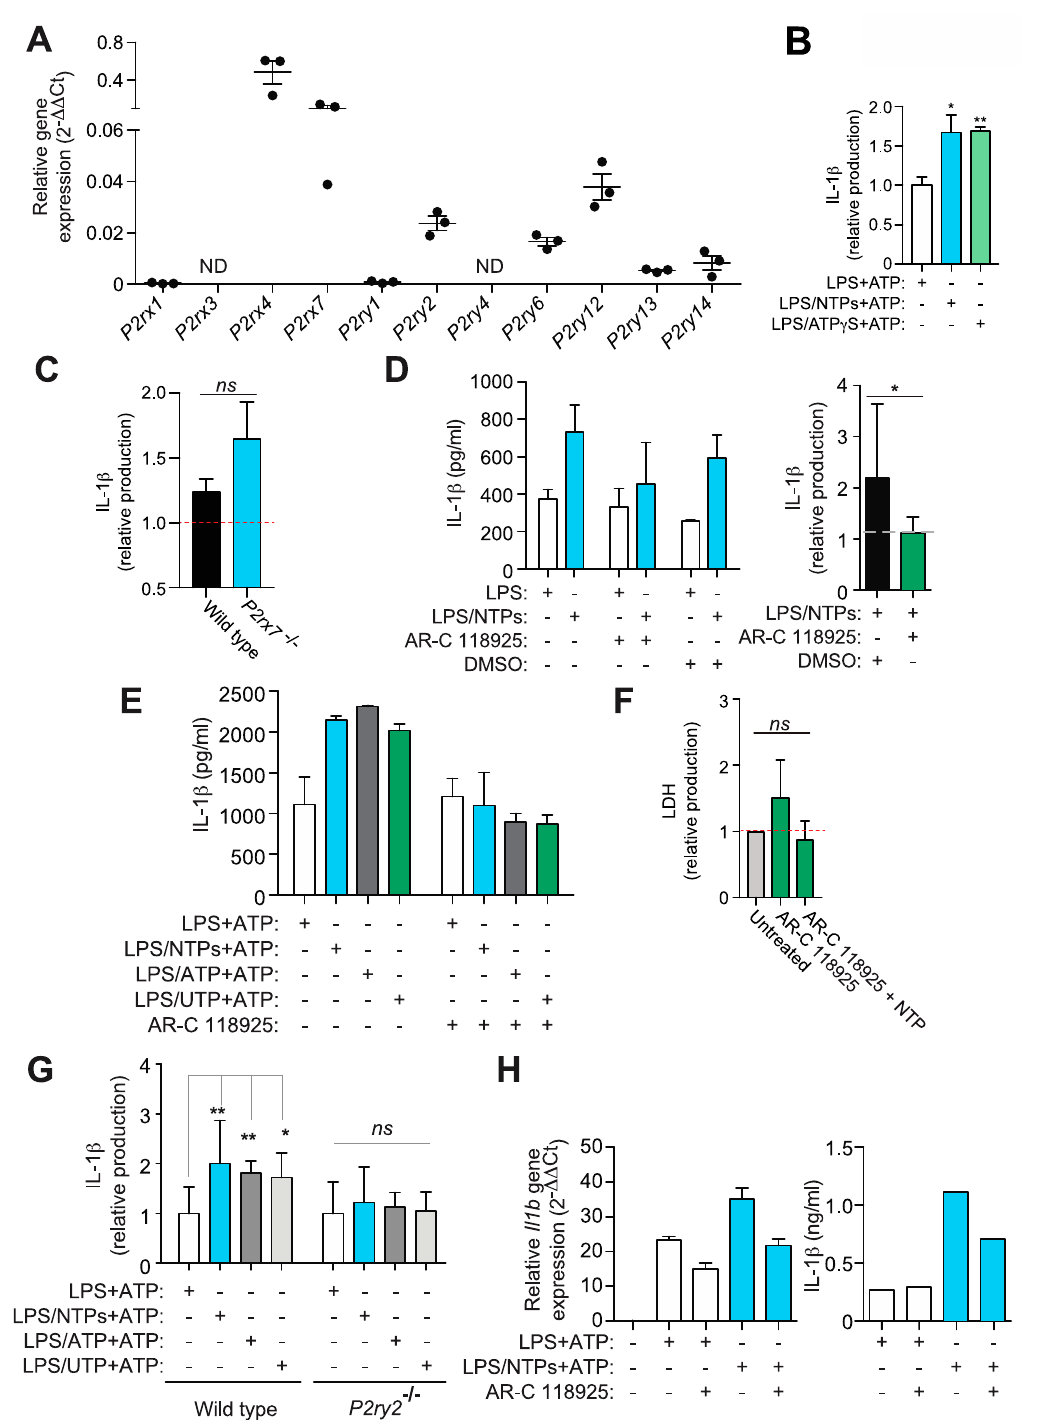
Figure 4. Nucleotides signal through P2Y 2 R to increase IL-1 β production. ( A ) Expression by qPCR of purinergic receptors from resting peritoneal macrophages (RPMs) from three experiments + SEM. ( B ) RPMs were treated with NTPs (blue bar, 20 µ M UTP / ATP) or ATP- γ S (green bar) for 10 min before adding LPS for 3 h and then NLPR3 inflammasome was activated using 3 mM ATP for 24 min. Supernatants collected were analyzed for IL-1 β production. Average of three experiments + SEM is shown. ( C ) Normalized IL-1 β release from wild type or P2rx7 − / − RPM primed with LPS + NTPs and then activated with nigericin; relative values to RPM primed with LPS alone and then treated with